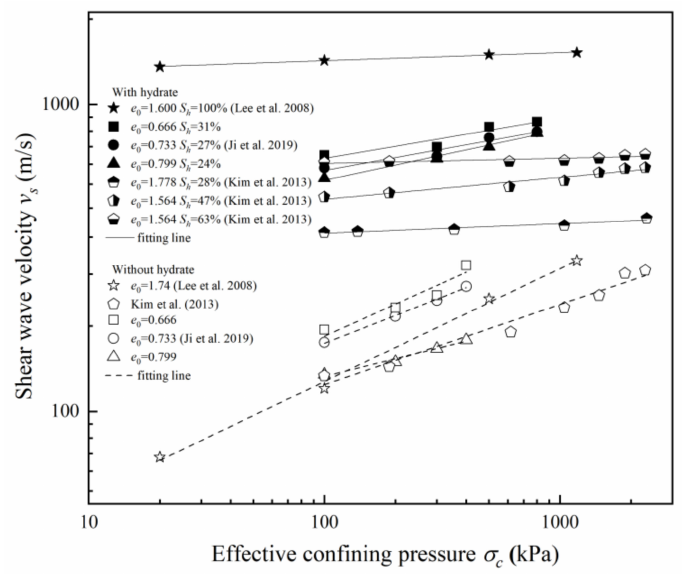
Figure 5. Comparison of the shear wave velocity of the CS–silt mixture with and without THF hydrate